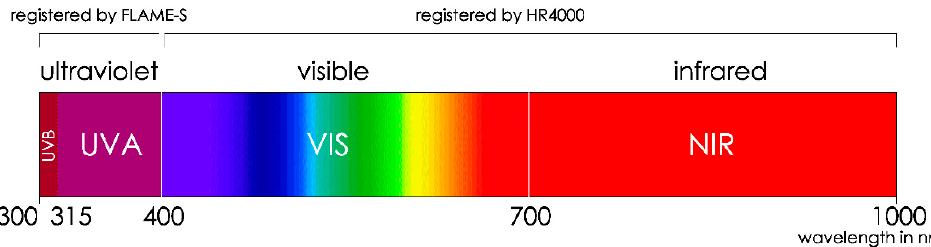
Figure 4. Spectral bands and corresponding wavelengths.